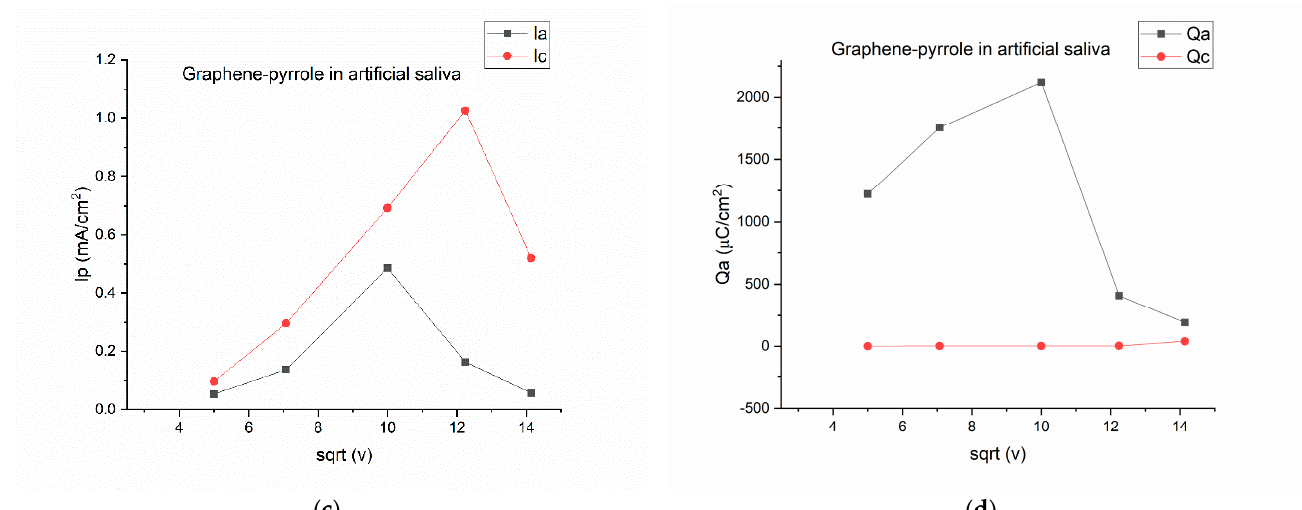
Figure 2. Electrochemical behavior of the composite in artificial saliva: ( a ) variation of the current- voltage characteristics at different scanning rates; ( b ) anodic/cathodic potential as function of the square root of the scanning rate; ( c ) anodic/cathodic peak intensity as function of the square root of the scanning rate; ( d ) total charge vs. the square root of the scanning speed.